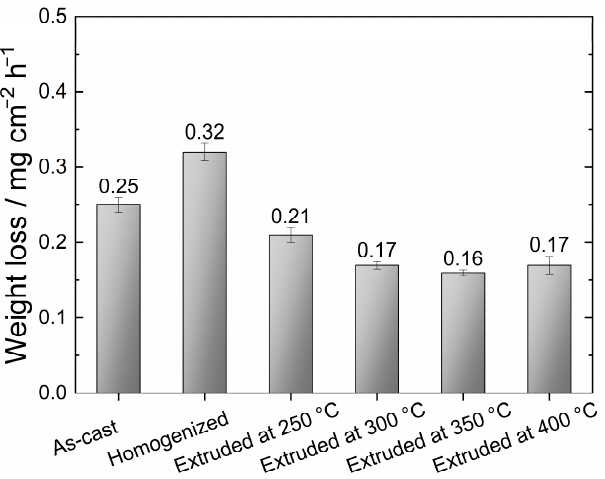
Figure 11. Weight loss of the alloys after 48 h of immersion in 3.5% NaCl solution.